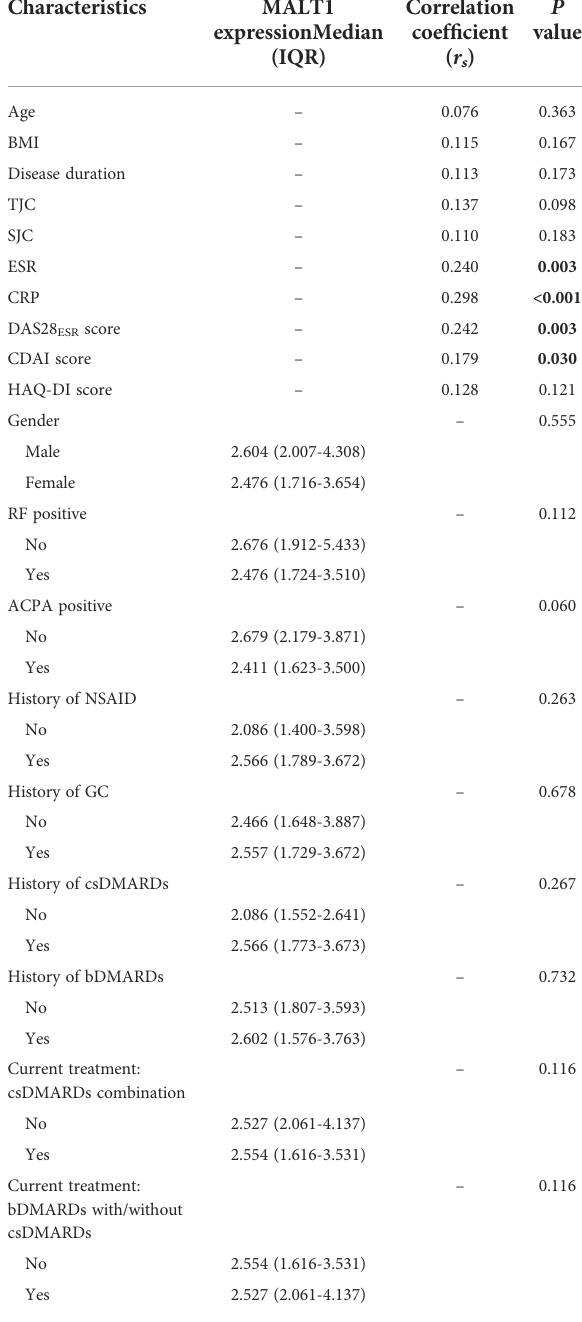
TABLE 2 Correlation of MALT1 expression with clinical characteristics in RA patients.